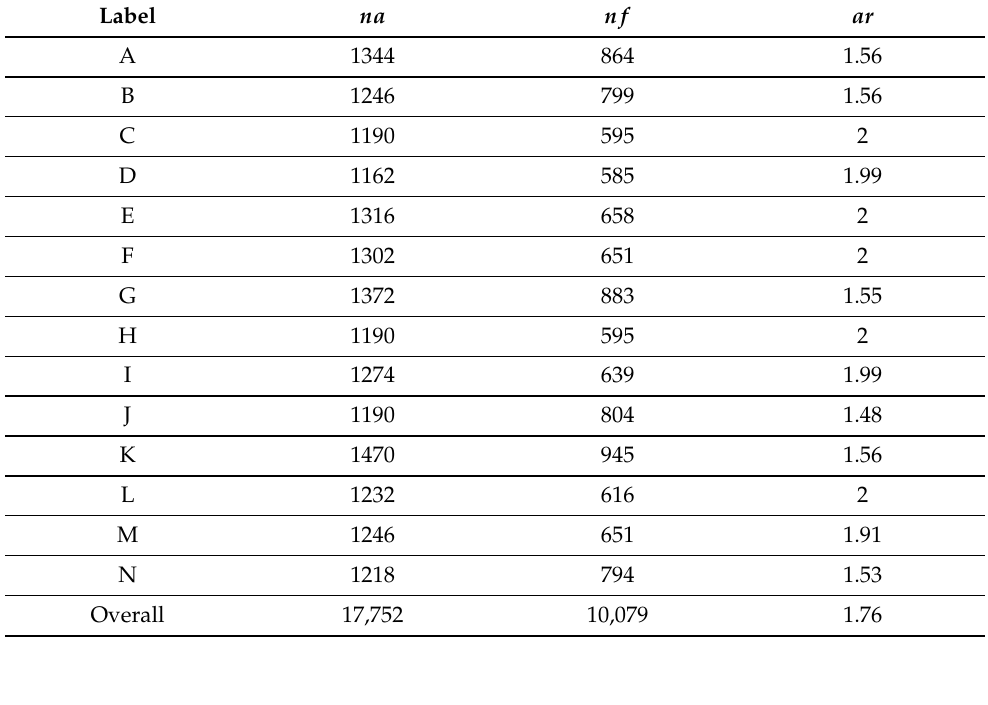
Table 5. Action filtering acceleration effect.